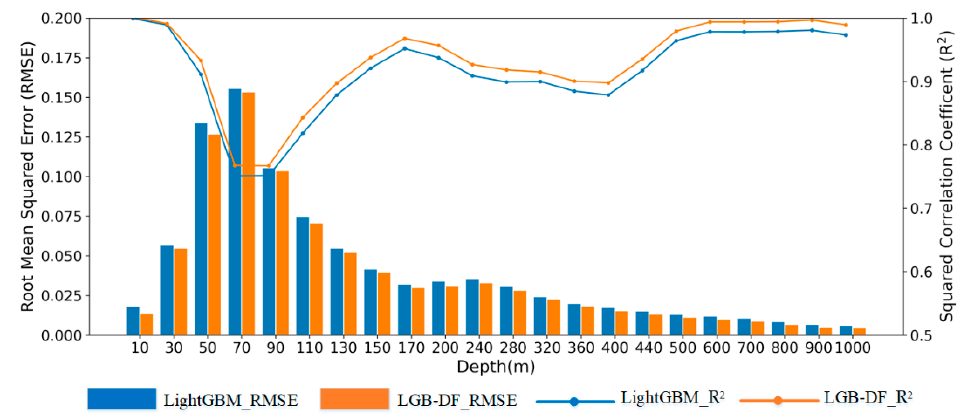
Figure 6. The average RMSE (psu) and R 2 of OSSS estimated using the LGB-DF model and LightGBM model at different depth levels in 2019 (the bars indicate the RMSE (psu) of the OSSS and the lines indicate the R 2 of the OSSS).